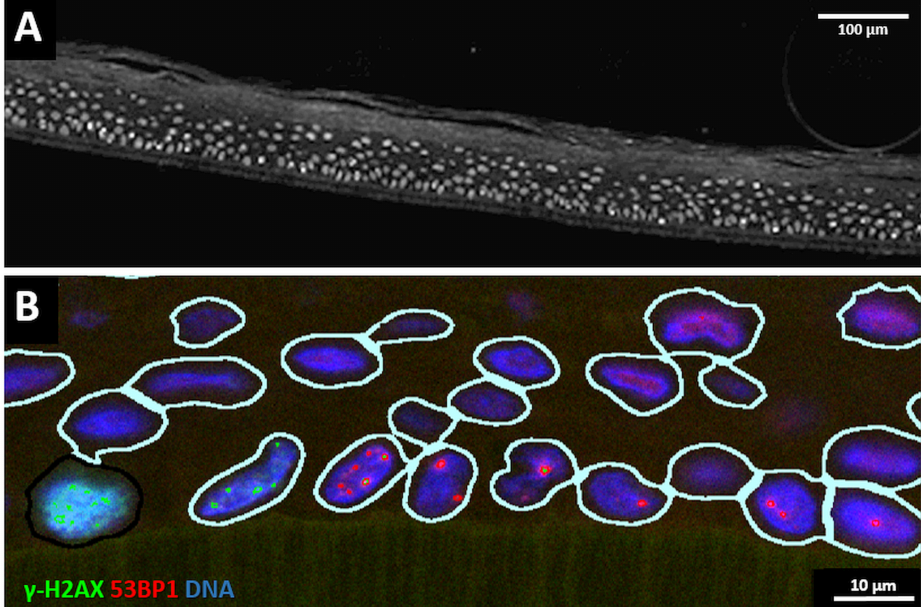
Figure 3. ( A ) Grayscale overview of a part of a cross-section of an epidermis model showing the DAPI-stained nuclei (greyish). The support membrane of the model is at the lower end; above it, the cells of the stratum basale are located, and the keratin layer of the stratum corneum is on top of the cell layers towards the top of the image. Bar: 100 µ m. ( B ) Example of nuclei identification and DNA damage analysis in a cross-section detail. The support membrane of the model is at the lower end. Nuclear contour masks (light lines) are generated around DAPI-stained nuclei (blue), 53BP1 DSB foci signals are displayed in red and γ -H2AX signals in green. The cell to the lower-left exhibits a nuclear pan- γ -H2AX signal. Bar: 10 µ m. For grayscale images of red and green channels, see Supplementary Figure